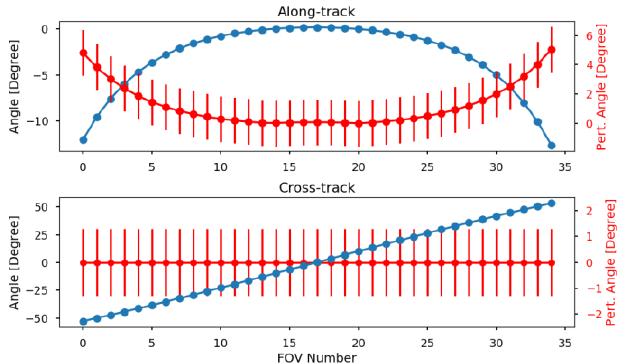
Figure 8. Example of the perturbation angle set up. The blue dots are the along-track and cross-track angles derived from the OMPS-NM geolocation dataset, which correspond to 𝜃 0𝑓𝑜𝑣 and 𝜃 0𝑓𝑜𝑣 in Equation (3). The red dots are the first guess angles that are 𝜃 𝑔𝑢𝑒𝑠𝑠𝑓𝑜𝑣 and 𝜑 𝑔𝑢𝑒𝑠𝑠𝑓𝑜𝑣 in Equation (3). The red bar indicates the perturbation range. In the along-track steps, the perturbation begins from −1.5 to 1.5 degrees with a step angle of 0.1 degrees (31 steps), while it is performed from −1.3 to 1.3 degrees with a step angle of 0.1 degrees (27 steps).